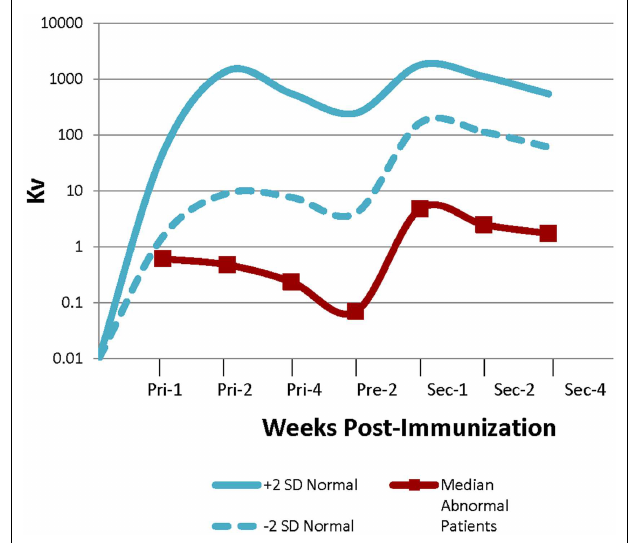
FIGURE 2 |Abnormal bacteriophage Φ X 174 results bacteriophage immunization results . Graph showing the range of normal bacteriophage ( ± 2 SDs) and the median values for the abnormal patients.Values were obtained 1, 2, and 4weeks after the primary immunization, prior to administering the secondary, and then 1, 2, and 4weeks after administration of the secondary immunization (4).